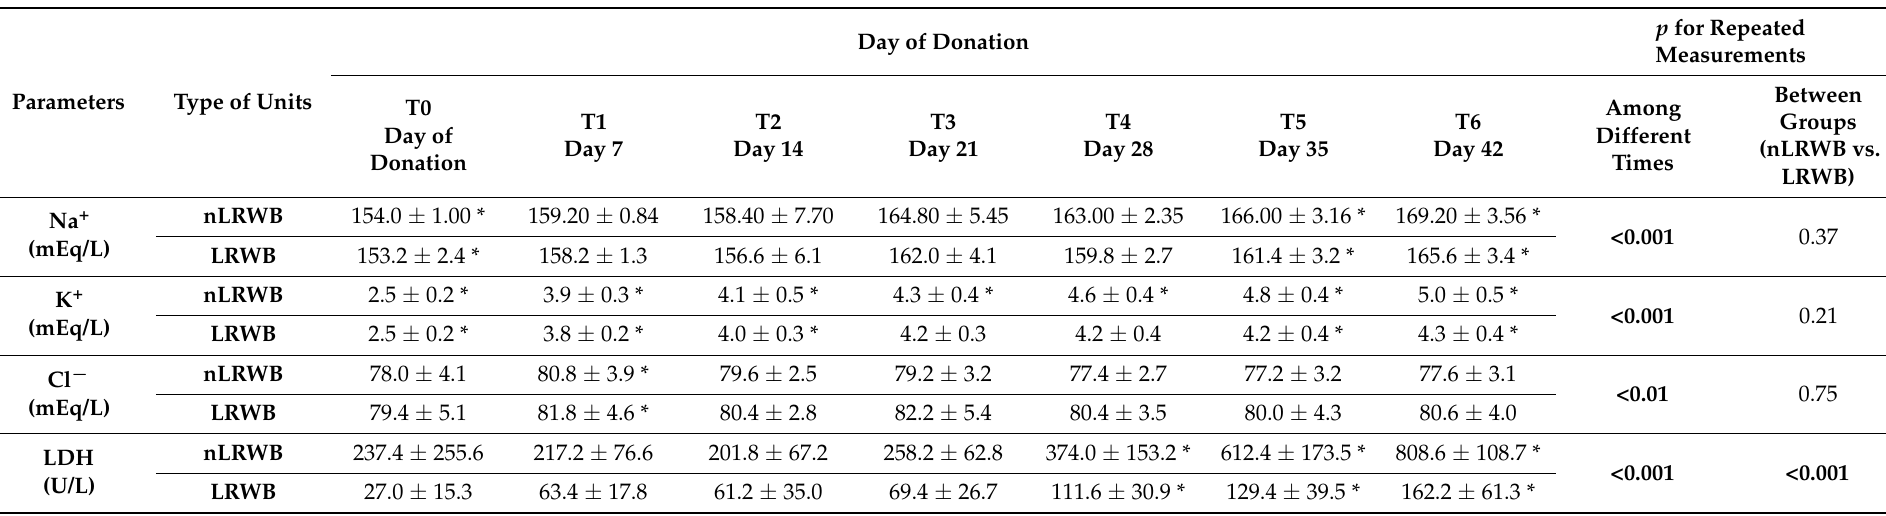
Table 2. Means ± standard deviations and significance of the parameters Na + , K + , and Cl − (mEq/L), LDH(U/L) in nLRWB and LRWB groups and in the different days post-donation.